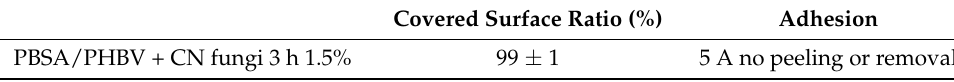
Table 5. Surface analysis of PBSA/PHBV films coated with chitin from fungi.